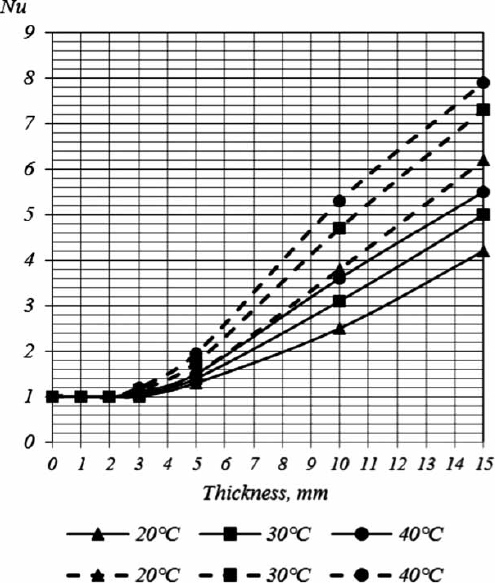
Fig. 3. The dependence of the Nu criterion of construction with impermeable thermal-insulating slabs on the thickness of small air gaps and difference in temperature: * non- ventilated small air gap; ---- ventilated small air